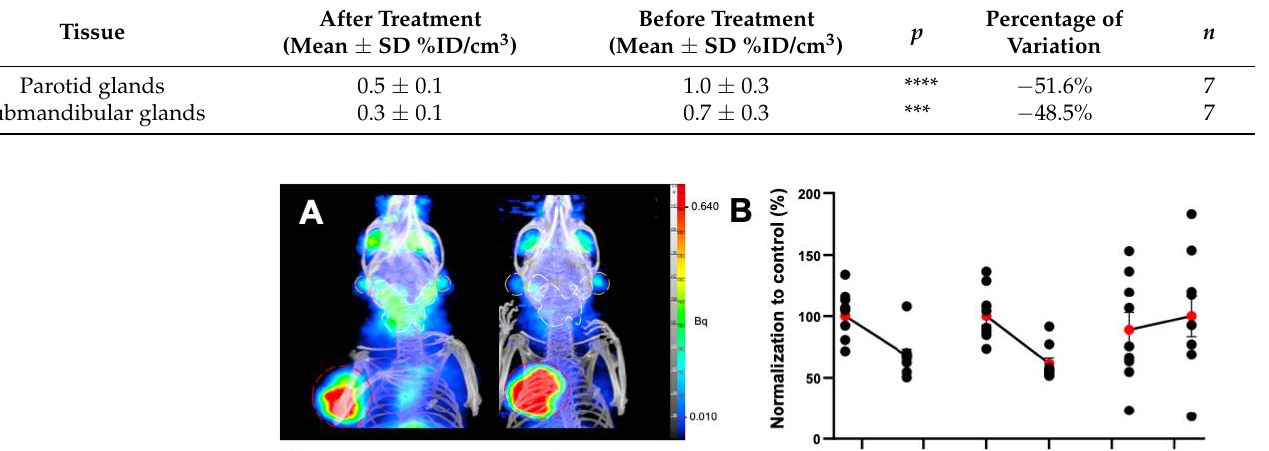
Figure 2. ( A ) Representative MIP images of microPET/CT biodistribution and the quantification of [ 68 Ga]Ga-PSMA-11 in the parotids and submandibular glands in non-tumor-bearing mice premedi- cated with atropine sublingually, at 15 mg kg −1 . The parotid glands are encircled in white and the submandibular glands are in orange. ( B ) Normalized quantification of [ 68 Ga]Ga-PSMA-11 in the parotids and submandibular glands in non-tumor-bearing mice. Red points represent the mean ± SEM; black points represent the sample dispersion. Table 3. Quantification of [ 68 Ga]Ga-PSMA-11 in the parotids and submandibular glands at 90 min after injection in non-tumor-bearing mice. Statistical tests have been performed by two-way ANOVA followed by a Sidak’s multiple comparison test. *** p < 0.001; **** p < 0.0001.